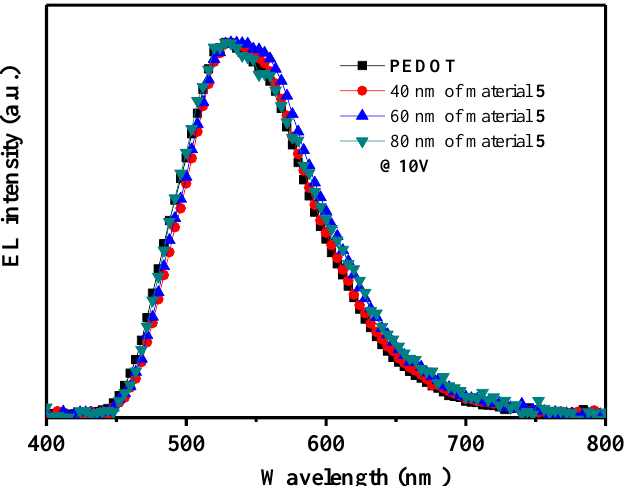
Figure 4. Electroluminescent spectra of the devices ITO/PEDOT or material 5 (40-60-80 nm)/Alq 3 /LiF/Al at voltage of 10 V.